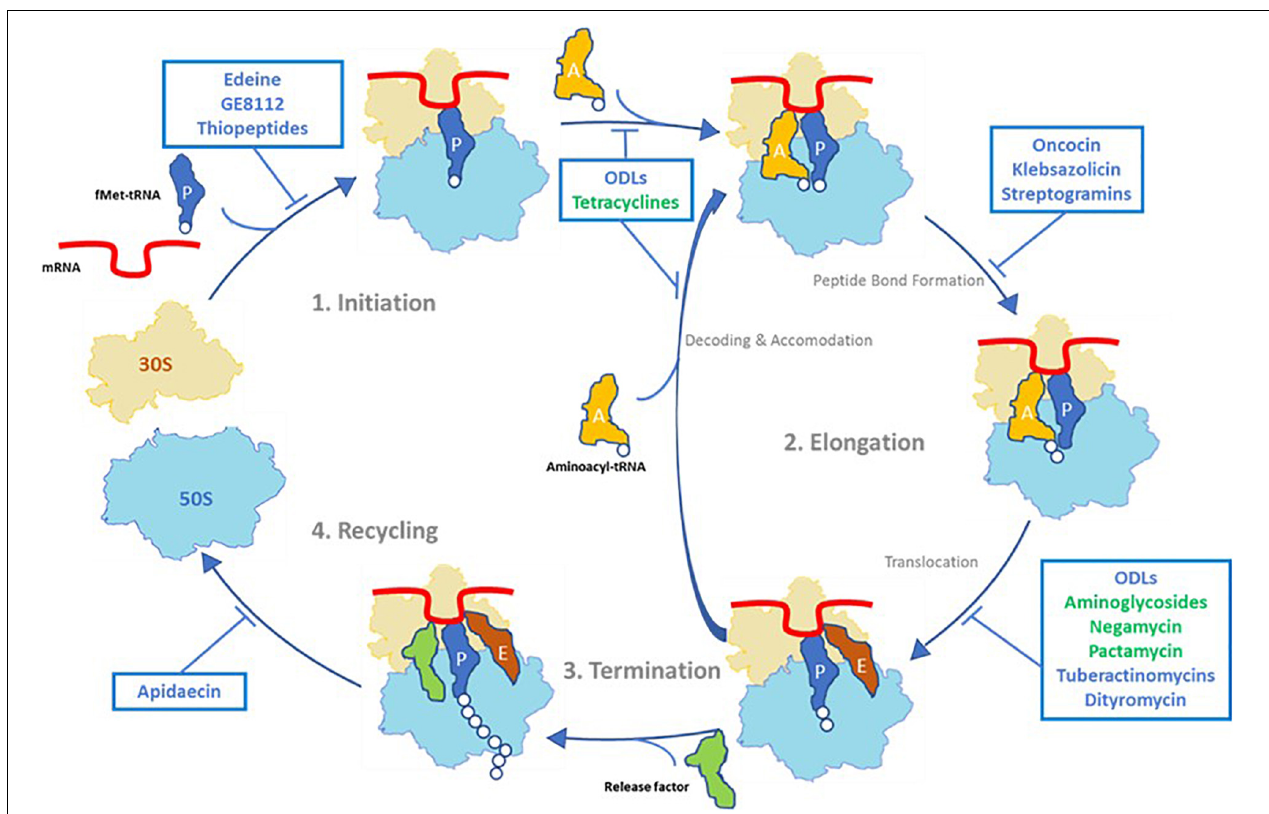
FIGURE 4 | Overview of antibiotics that target the 30S ribosomal subunit (in green) and antibacterial peptides that inhibit the prokaryotic translation cycle (in blue).